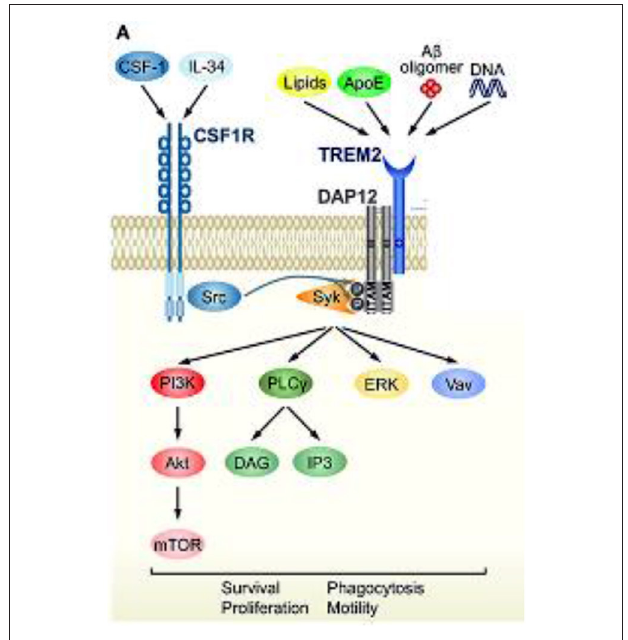
FIGURE 4 | TREM2 signaling cascade and convergence with CSF1R signaling. Schematic representation of TREM2/DAP12 signaling in microglia. Ligands and downstream signaling of TREM2/DAP12. Of the known TREM2 ligands, only ligands that highly correlate with neural diseases are shown. Upon ligand binding to TREM2, two tyrosine residues within the ITAM motif of DAP12 are phosphorylated, which recruits Syk kinase to activate downstream signaling molecules, such as ERK, PI3K, PLC γ , and Vav. Src, the main effector of CSF1R, is a kinase supposed to phosphorylate the ITAM tyrosine residues. Reprinted with permission form